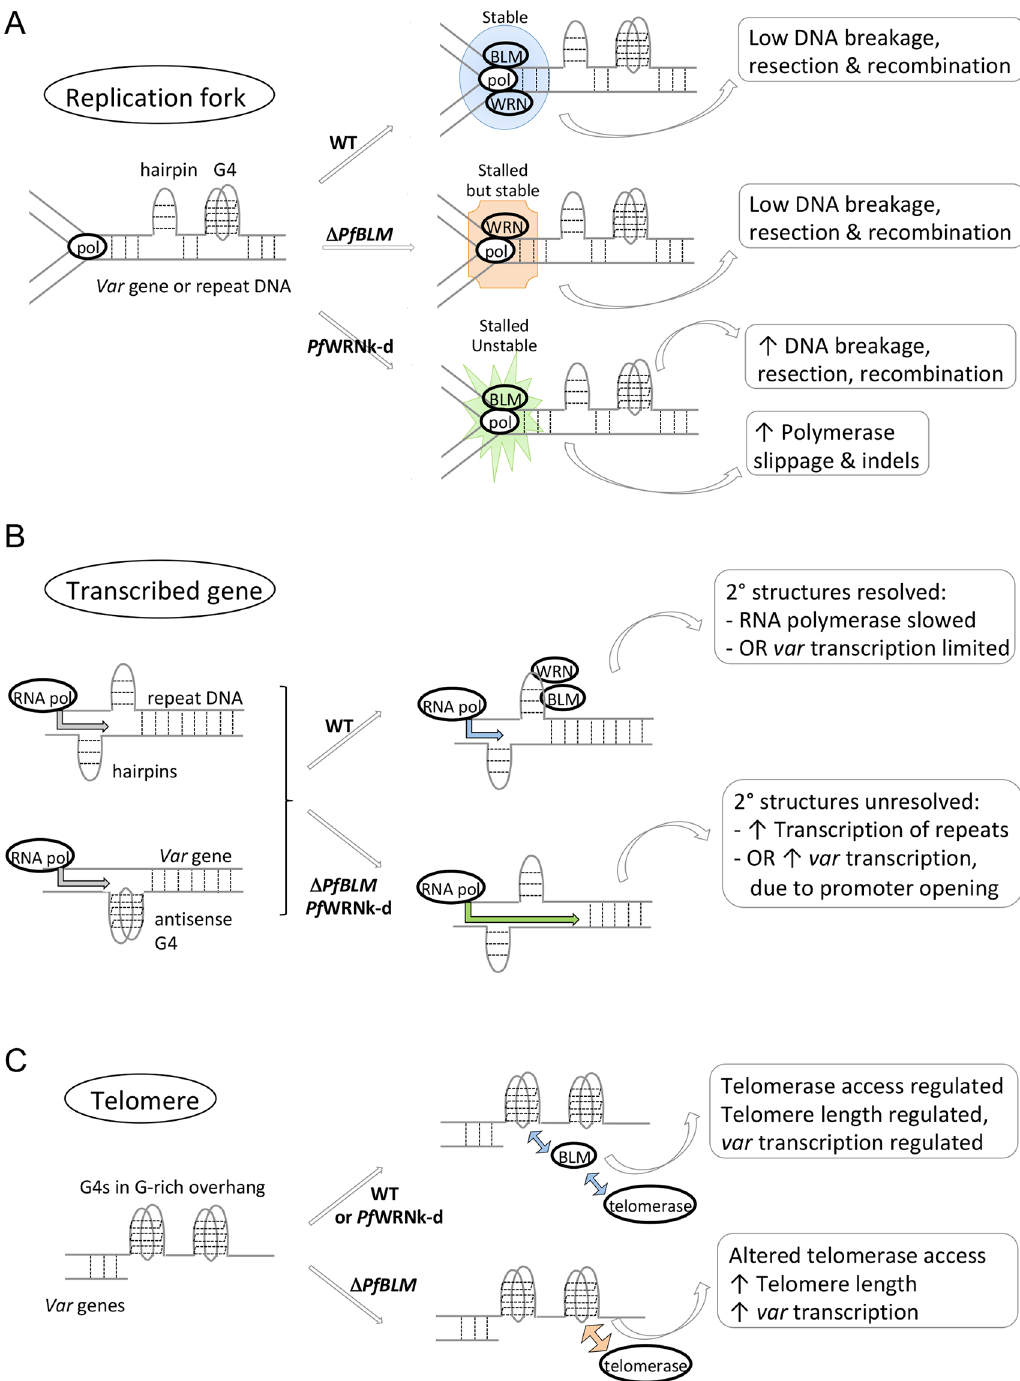
Fig 6. Schematic summarising the roles of RecQ helicases in P . falciparum . The schematic shows proposed helicase roles at replication forks (A), transcribed genes (B) and telomeres (C).